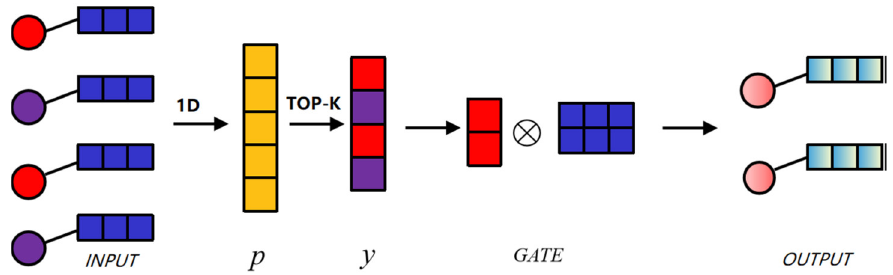
Figure 3. An illustration of the proposed signed graph pooling layer with k = 2. We consider four nodes from balanced node set, and each node has 3-dimension features. The yellow block is the trainable projection vector. After that, we can select the top two nodes. After the gate stage, we can achieve the new output.